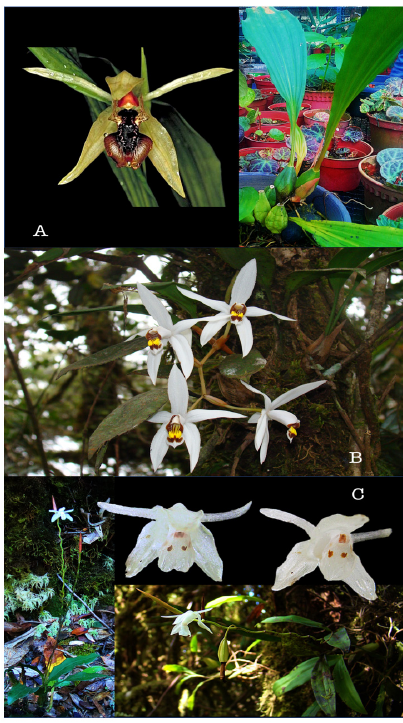
Figure 1. The three endemic Coelogyne species in Peninsular Malaysia. ( A ) Coelogyne tiomanensis; ( B ) Coelogyne kaliana and ( C ) Coelogyne stenochila (all with flower and vegetative